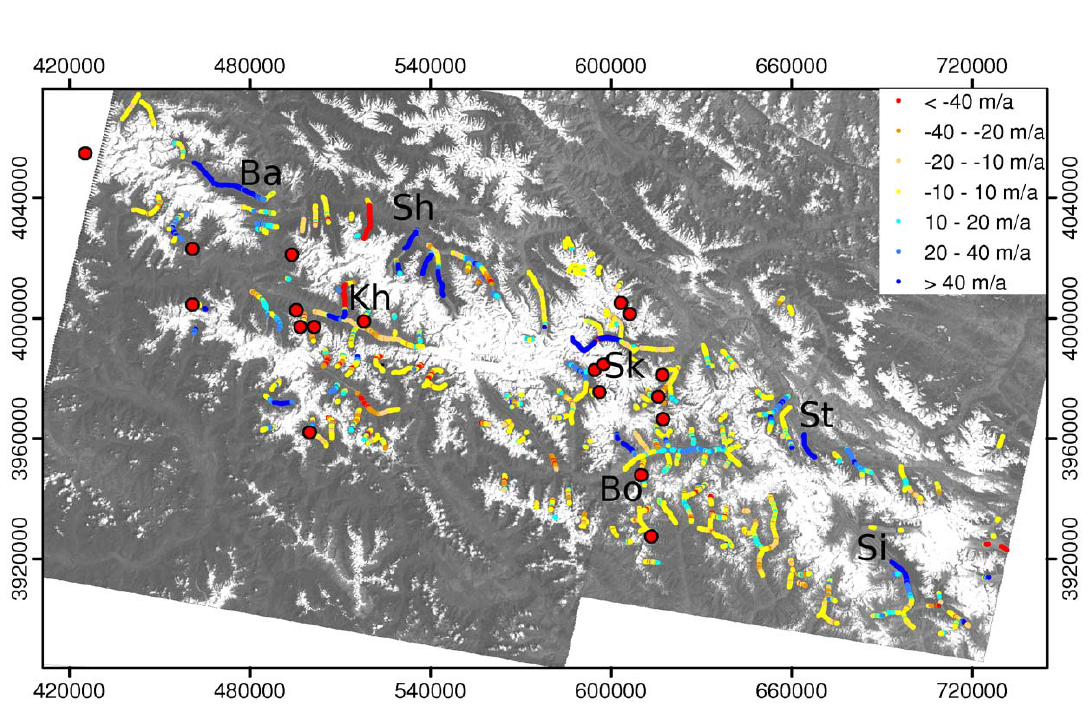
Fig. 3. Differences in centerline speed in Karakoram between the two periods 2001–2002 (east)/2000–2001 (west) and 2009–2010. Negative values indicate lower speeds in the last period. Changes between − 10ma − 1 and 10ma − 1 are insignificant. Note that the scale is different compared to Fig. 2. The large red circles indicate glaciers that are known to surge (Hewitt, 1969, 2007; Copland et al., 2009). Ba indicates Batura, Bo indicates Baltoro, Sh indicates Shimshal valley, Kh indicates Khiang, Sk indicates Skamri, St indicates Stanghan and Si indicates